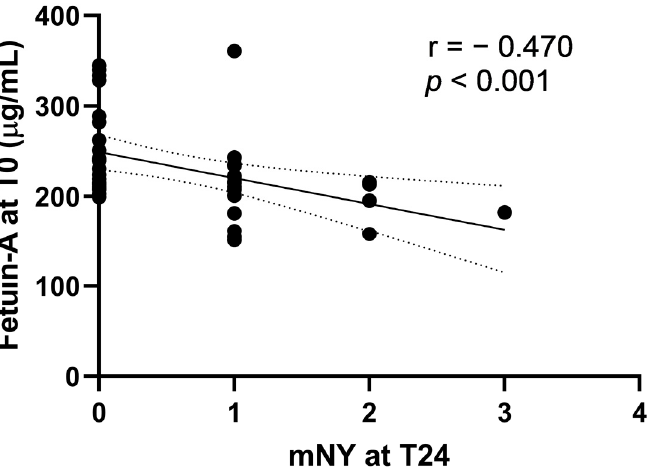
Figure 4. Scatterplot: Association of Fetuin-A at T0 and of mNY at T24.